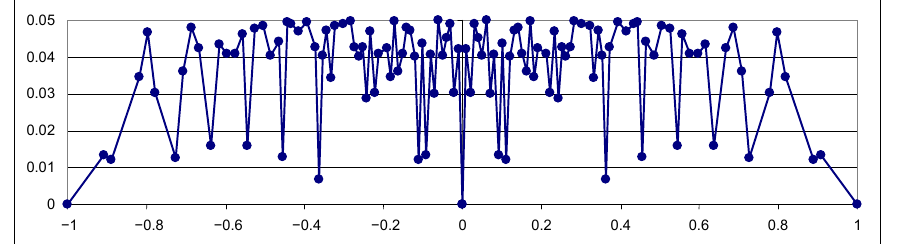
Non-CP of CIs for ER ( x / m − y / n ), as function of ER, for m = 9, n = 11, x from 0 to m , y from 0 to n group of experiment configurations when the imposed level is set to 0.05 (5%). Here, ( u , v ) sampling is ruled by the bivariate binomial with the probability BS( u ; x , m ) · BS( v ; y , n ). Figure 14. CI ER,5% (0..9, 0..11, 9, 11) non-CP for sampling with replacement.